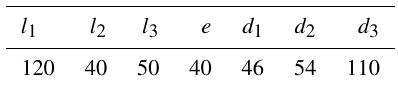
Table 1. Geometric parameters of the metamorphic quadruped robot with the units of